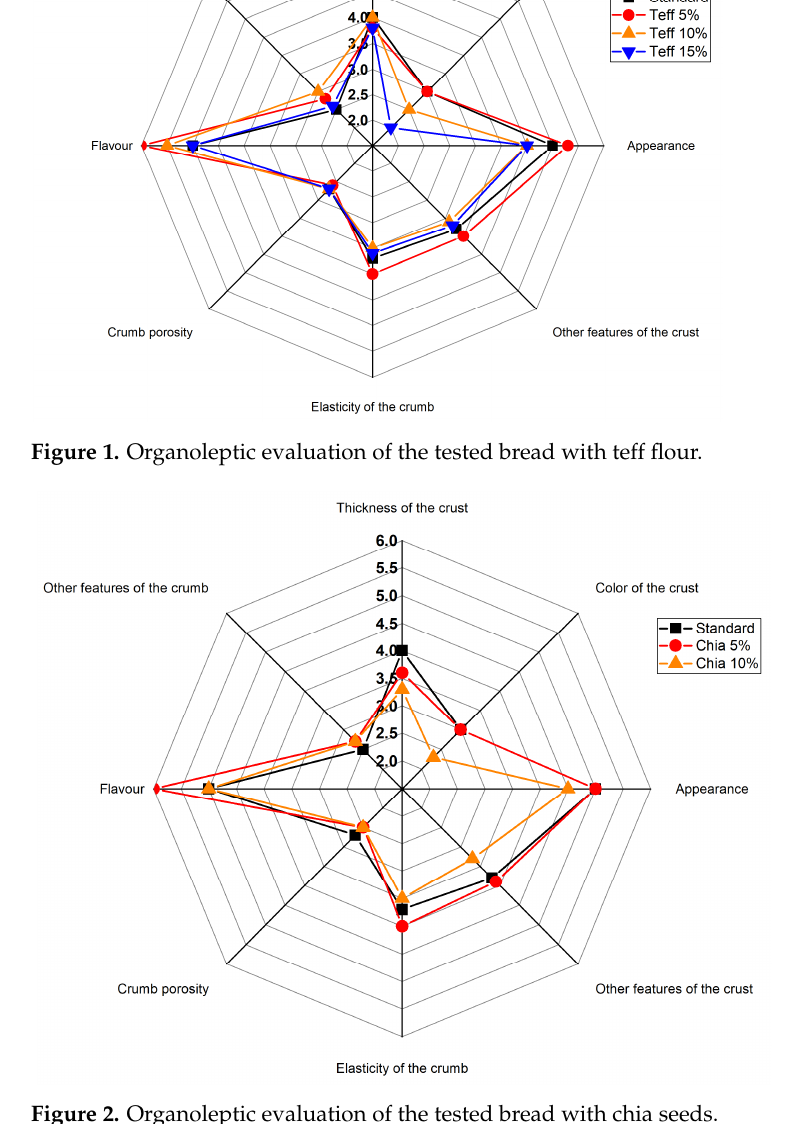
Figure 2. Organoleptic evaluation of the tested bread with chia seeds. Bread with teff flour was assessed more critically during studies by other authors.